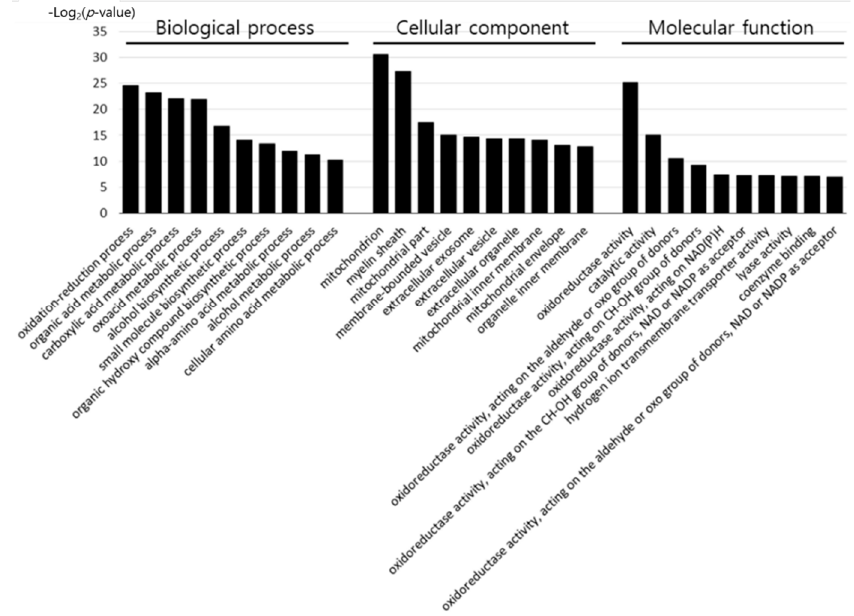
Figure 3. GO terms of genes encoding the differentially expressed proteins ameliorated by early heat exposure.